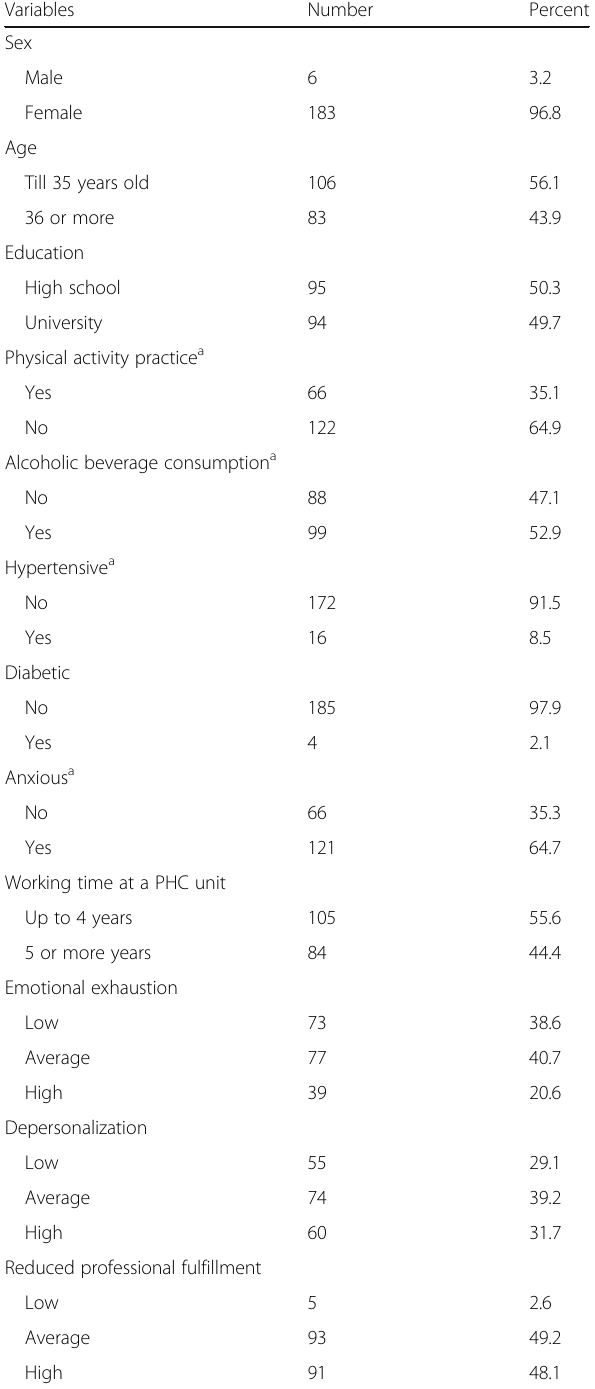
Table 1 Sociodemographic and occupational characteristics, lifestyle, morbidity of the population as important variables for the predictive model ( N = 189), Bahia, Brazil